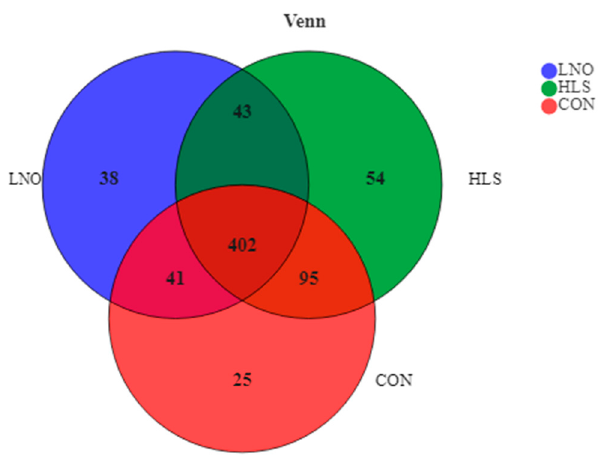
Figure 3. Venn plot of operational taxonomic units (OTUs) showing the percent of observations for each OTU (>0.5%) present in each dietary group (flaxseed oil, LNO, heated flaxseed grain, HLS, CON). Each color represents one treatment: The red represents kids fed the basal diet (CON), the blue represents kids fed the basal diet supplemented with flaxseed oil (LNO), and the green represents kids fed the basal diet supplemented with heated flaxseed grain (HLS).